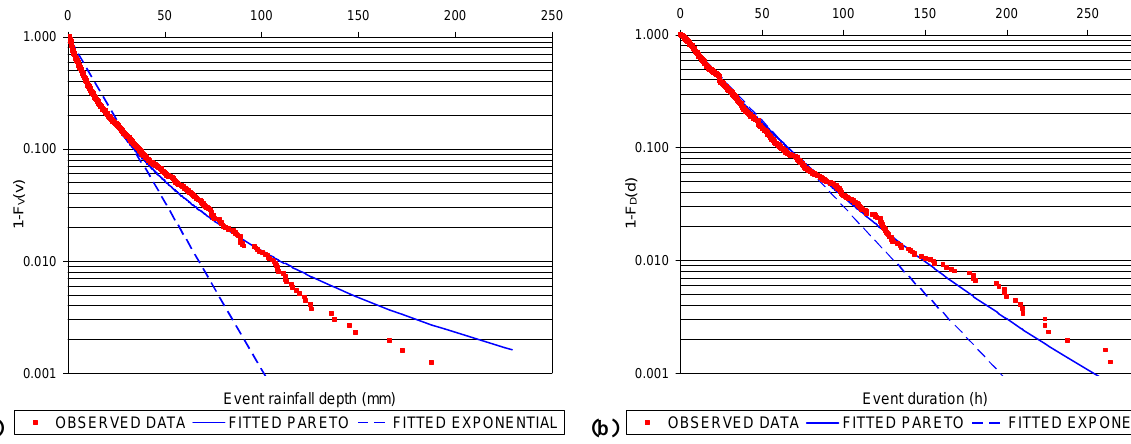
Fig. 7. Exponential and alternative probability distributions for rainfall event depth and duration (Santander